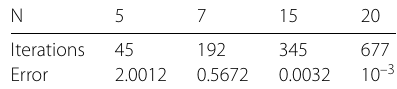
Table 1 Iterations and errors for Algorithm